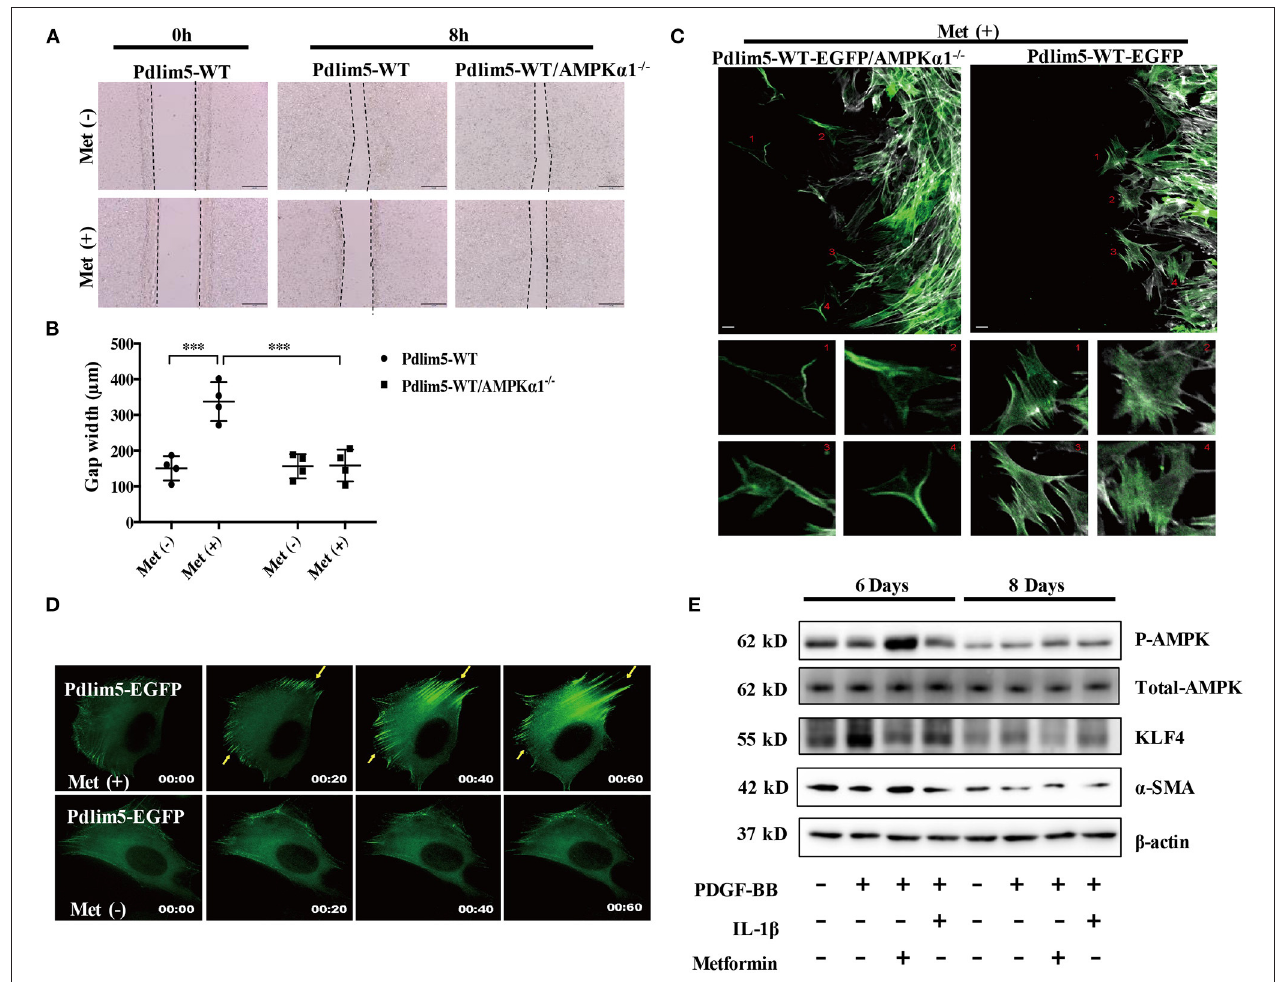
FIGURE 1 | Metformin inhibits vascular smooth muscle cell (VSMC) migration through the AMPK–Pdlim5 pathway. (A) EGFP-Pdlim5 VSMCs and AMPK α 1-null/EGFP -Pdlim5 VSMCs were stimulated with metformin (1mM) for 8h in a scratch assay. (B) Bar graph showing the gap width 8h after scratching [from (A) ]. Data are representative of means ± SEM from four independent experiments. The significance of differences between series of results was assessed using one-way analysis of variance, followed by a post-hoc comparison with Dunnett’s method for multiple comparisons. *** P < 0.001, n = 4. (C) GFP images of AMPK α 1-null/KDR/EGFP-WT-Pdlim5 cells before and after metformin stimulation (1mM). The magnified images below show the cells labeled by the number. Scale bar, 10mm. (D) Time-lapse images of GFP signal in EGFP-WT-Pdlim5 cells with or without metformin stimulation (1mM). Yellow arrowheads indicate the growth of dorsal stress fibers from the opposite side in EGFP-WT-Pdlim5 cells after metformin stimulation. Scale bar, 10mm. (E) Western blot of vascular smooth muscle cell (VSMC) contractile markers SMA, transcriptional regulator KLF4, and phosphorylated AMPK in control, PDGF-BB-treated, metformin combined with PDGF-BB and IL-1 β combined with PDGF-BB-treated